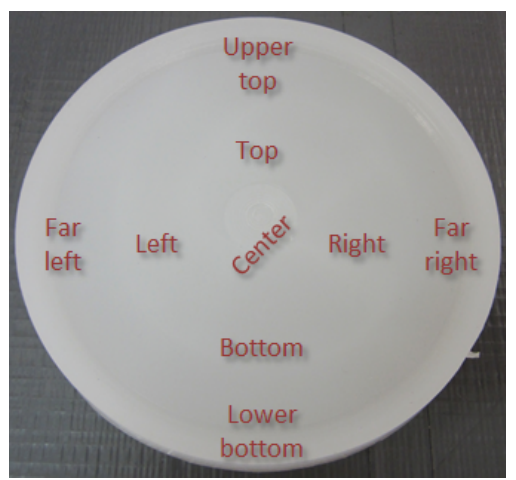
Figure 3. Measurement positions on PE-Xa samples.